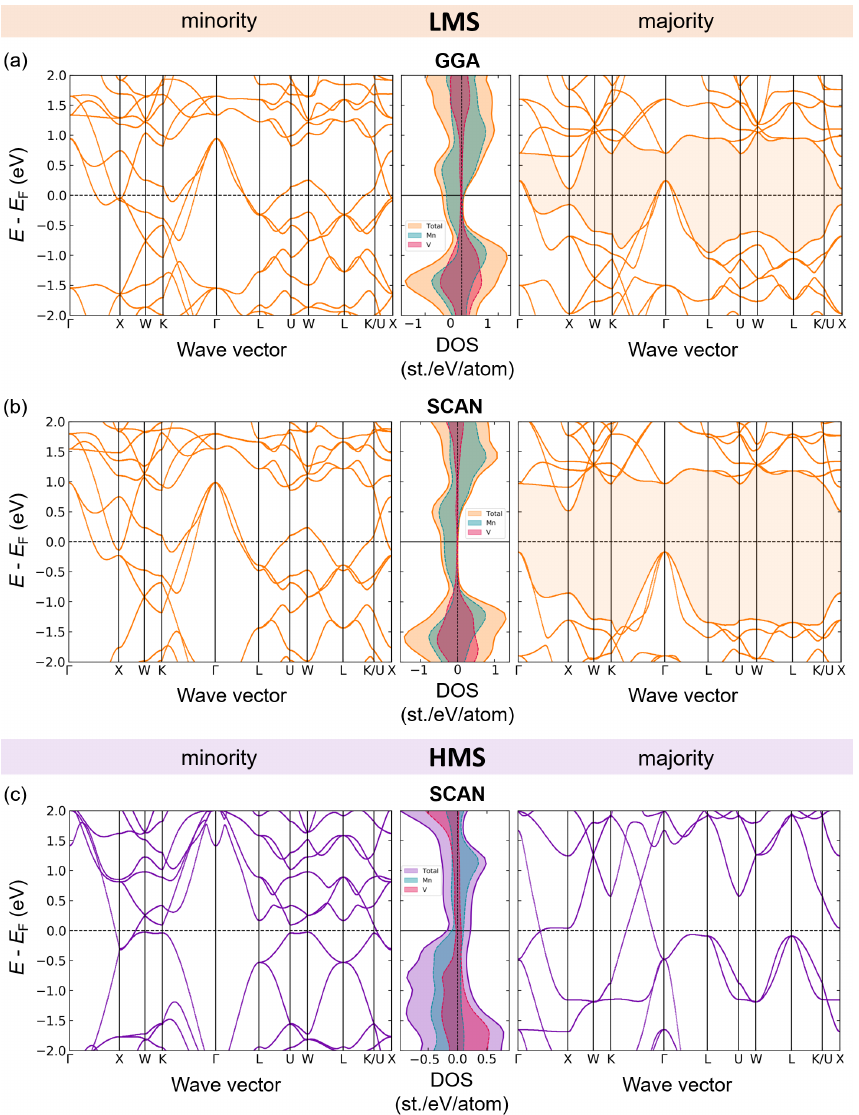
Figure 22. Minority and majority band structures and total and partial DOSs for Mn 2 VGe. ( a ) GGA results for LMS. SCAN results for ( b ) LMS and ( c ) HMS at their equilibrium volumes. Figure adapted from Ref. [64].